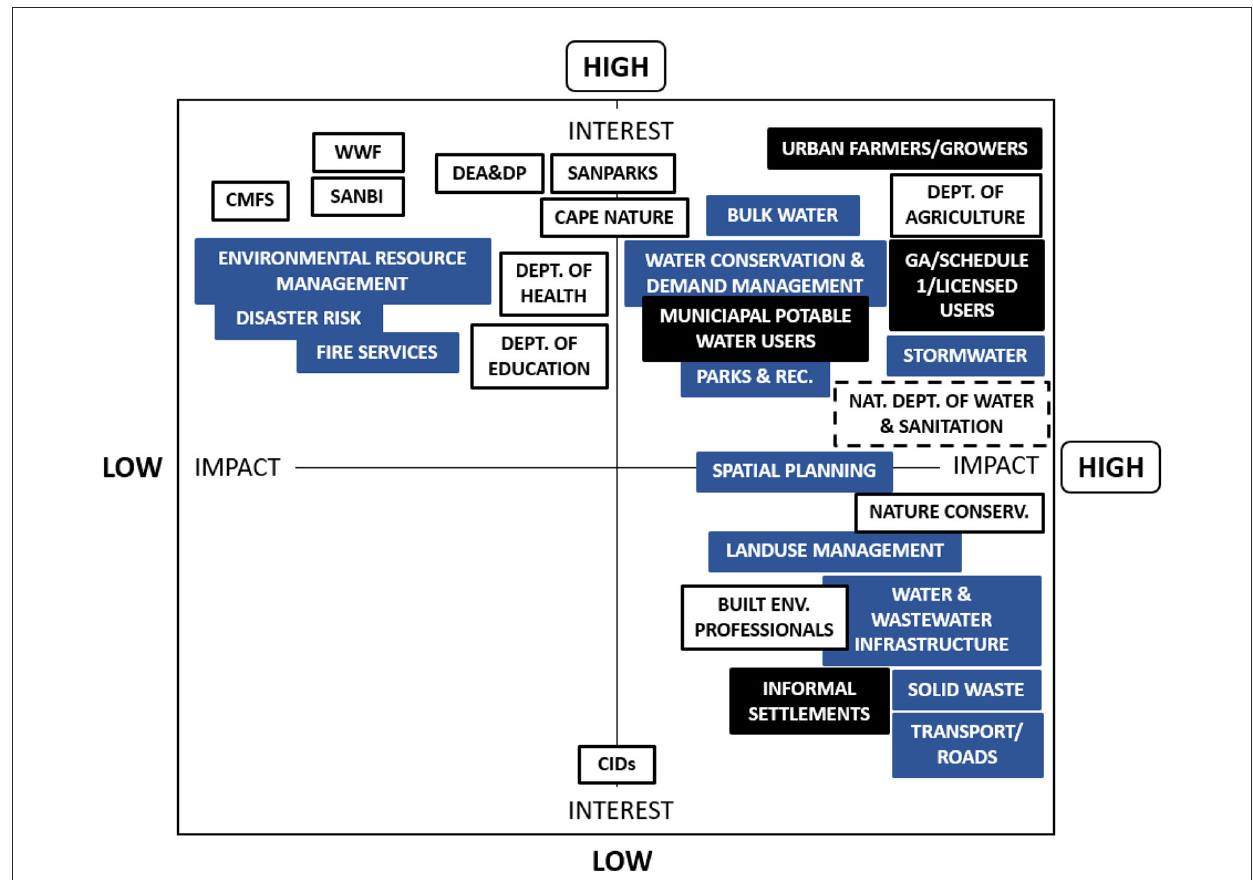
FIGURE5 Stakeholder mapping adapted from National Department of Water and Sanitation (2017); Source: Faragher (2022).